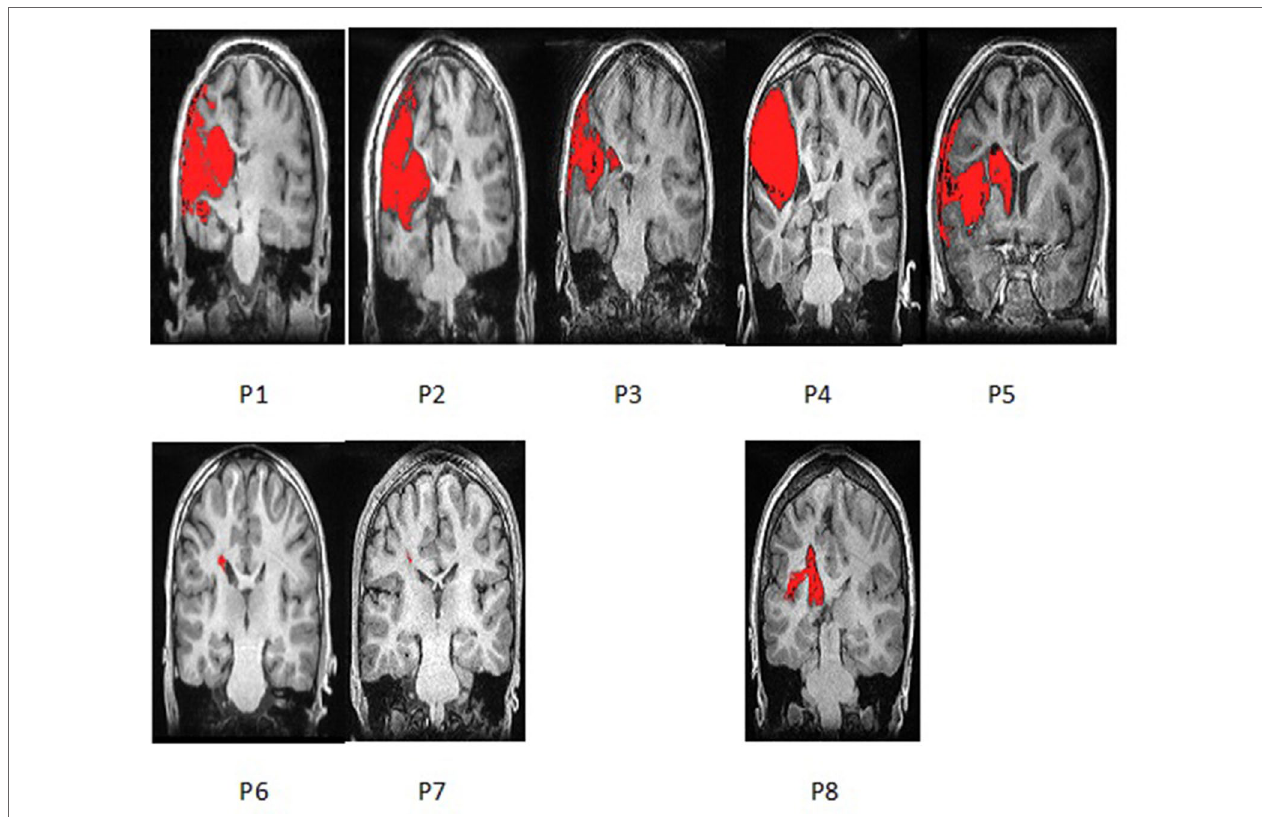
FIgURE 1 | Coronal section of T1 Structural MRI of all eight patients showing their brain lesions (lesion represented in red color). Images are presented via MRICron and therefore flipped—left side of the brain is on the left side of the